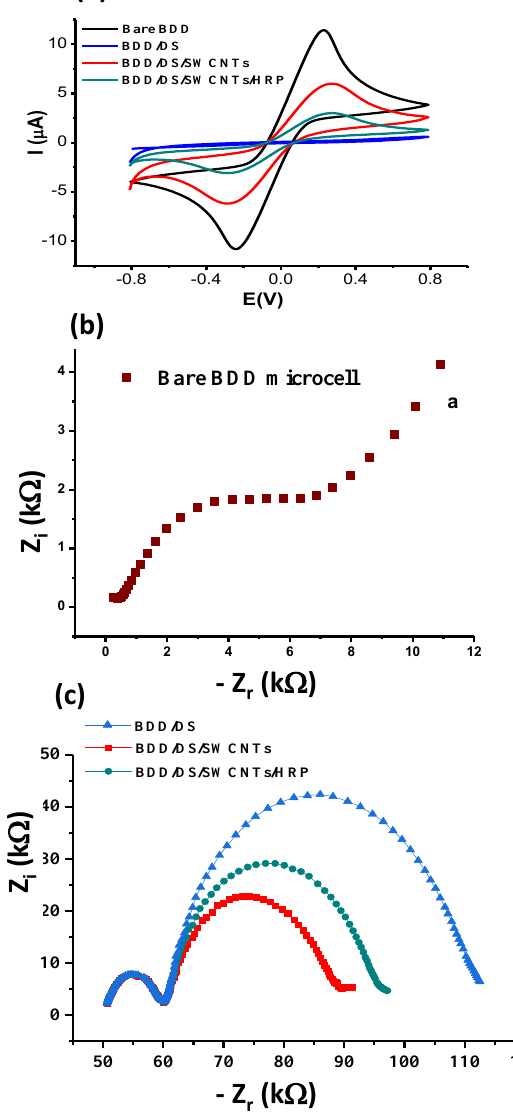
Figure 4. ( a ) Cyclic voltamograms, and ( b , c ) Nyquist plots obtained after the different steps of fabri- cation of the biosensor: ( b ) Bare BDD, ( c ) BDD-SD (red curve), BDD-SD-SWCNTs (blue curve), and BDD-SD-SWCNTs-HRP (green curve) Measuring media: 0.1 M of PBS with 5 mM of Fe 3+ /Fe 2+ probe.